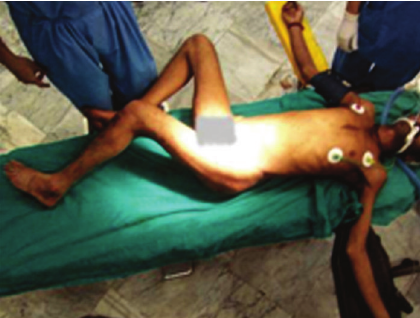
Figure 3: Radiograph of the pelvis of the same patient showing reduction of the dislocated